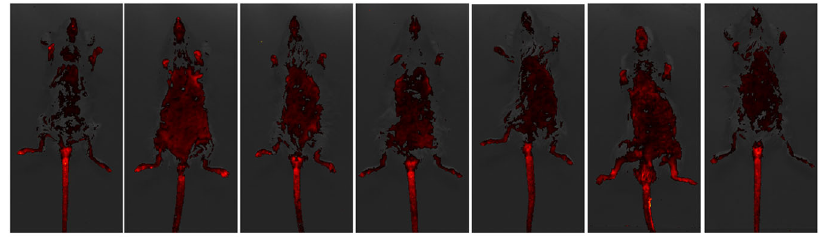
Fig. 3 In vivo whole-body fl uorescence images of mice with intravenous injection of the BCQD@Mn at different time points ( n =